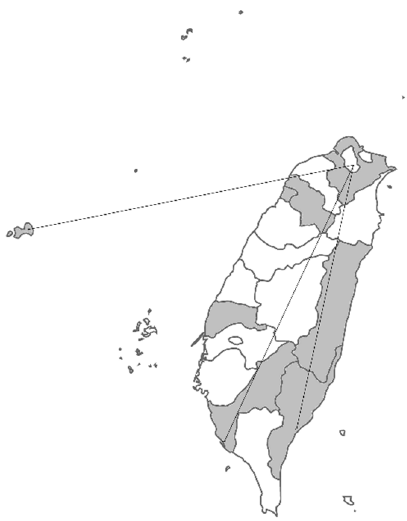
Figure 3. The coverage map of the National Taiwan University Hospital Newborn Screening Center. The samples ship from the gray areas to our screening center, designated by the government, including the three far areas indicated by the lines. The distances from the birthplaces to the screening center were around 300 km.